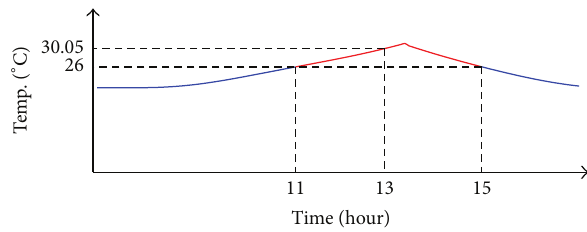
Figure 9: SmartSantander sensor values of the temperature for a specific period in a